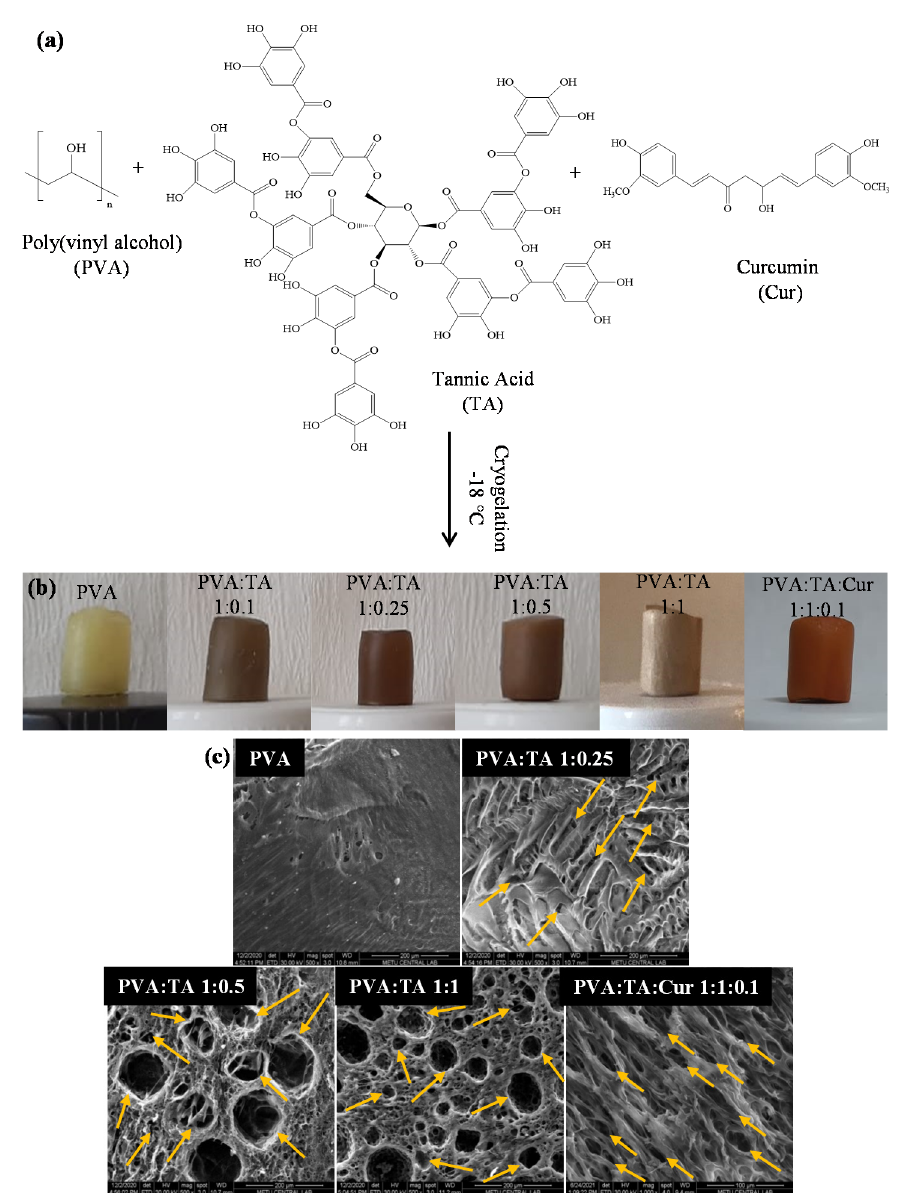
Figure 1. ( a ) Schematic representation, and (b) digital camera images of PVA cryogel, PVA-TA cry- ogel composites, and PVA-TA-Cur cryogel composites, and (c) their SEM images. As can be seen from Figure 1b, physically crosslinked opaque brown PVA:TA and trated porous cryogel networks through